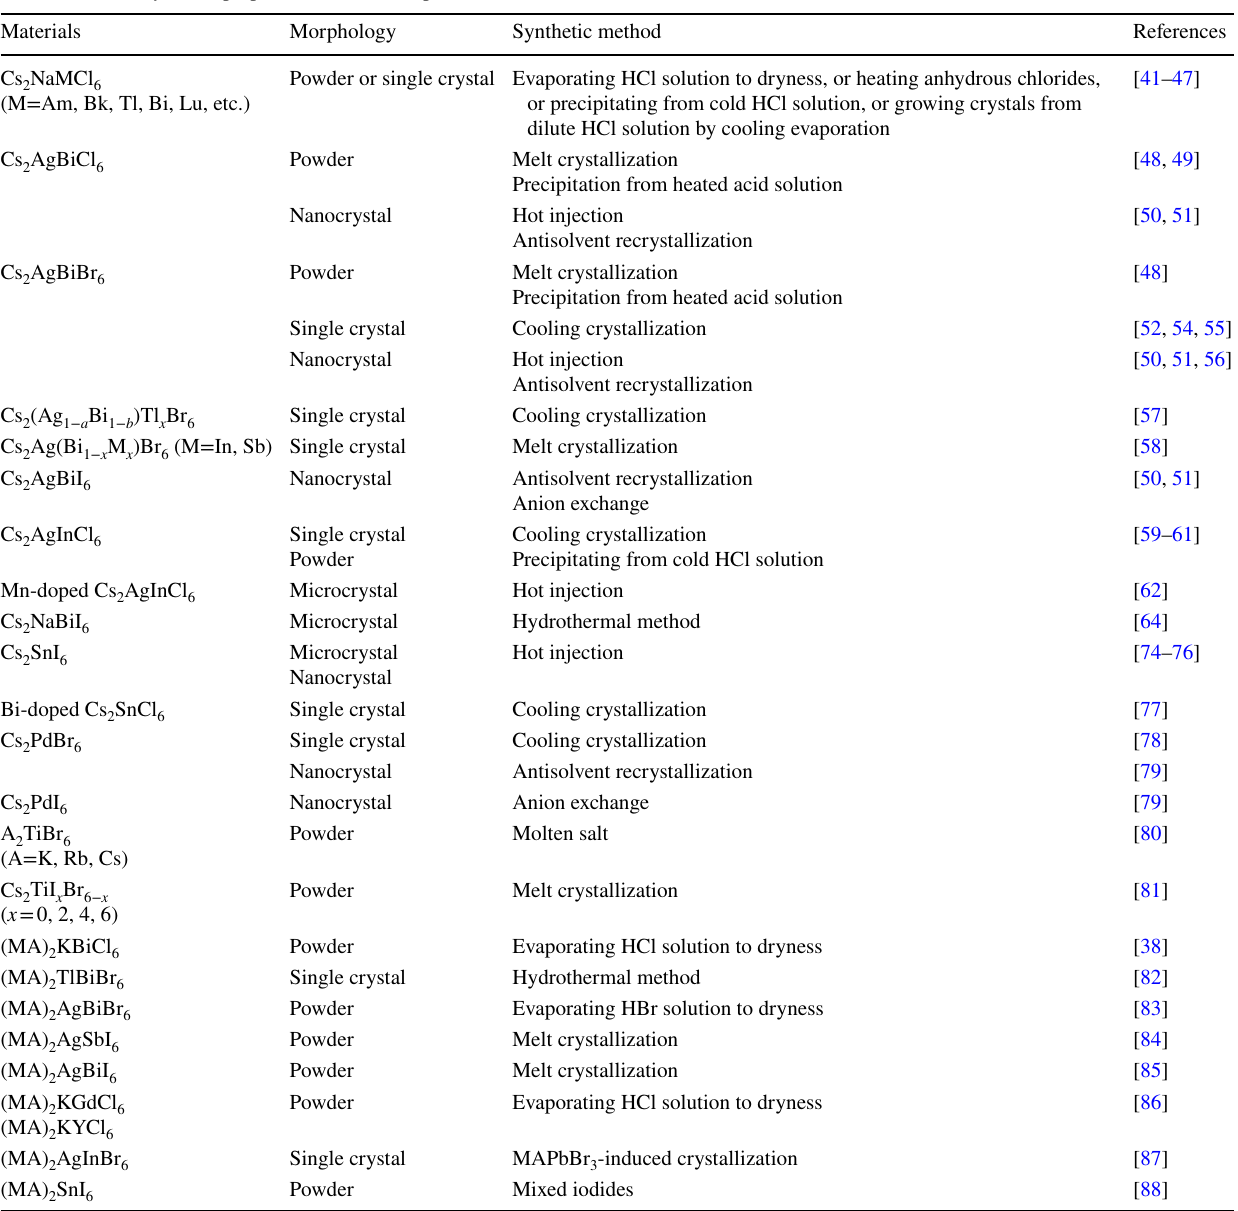
Table 1 Summary of the prepared halide double perovskites Materials